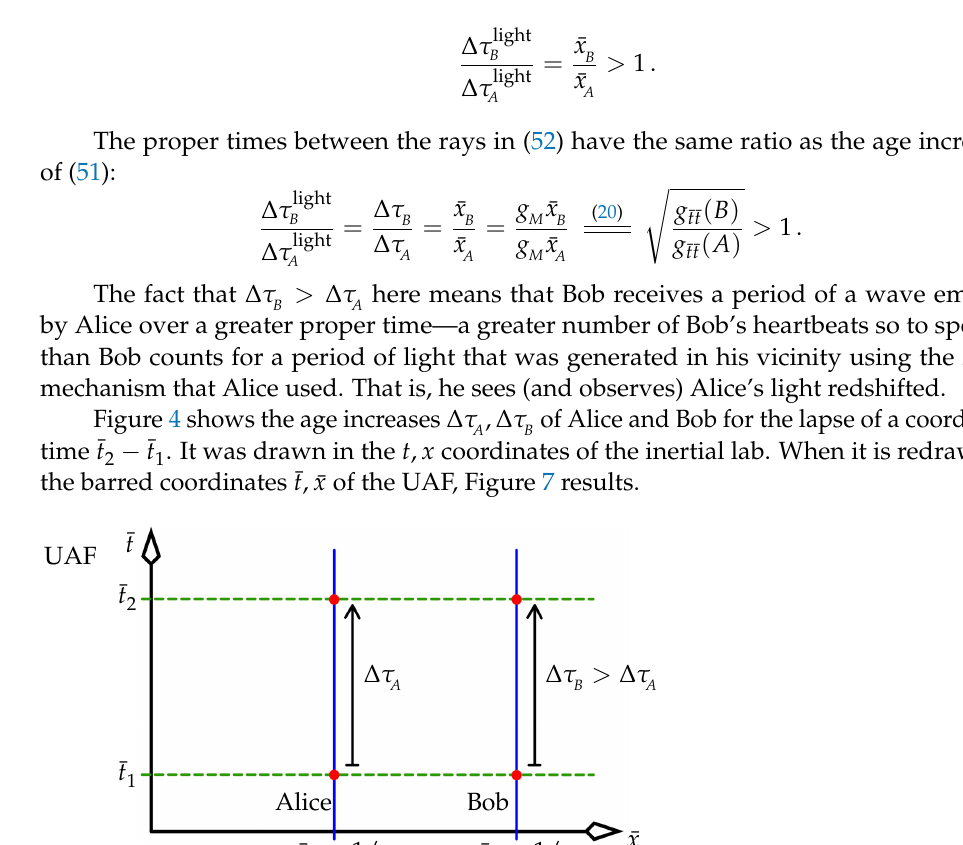
− ¯ t . We did that 2 1